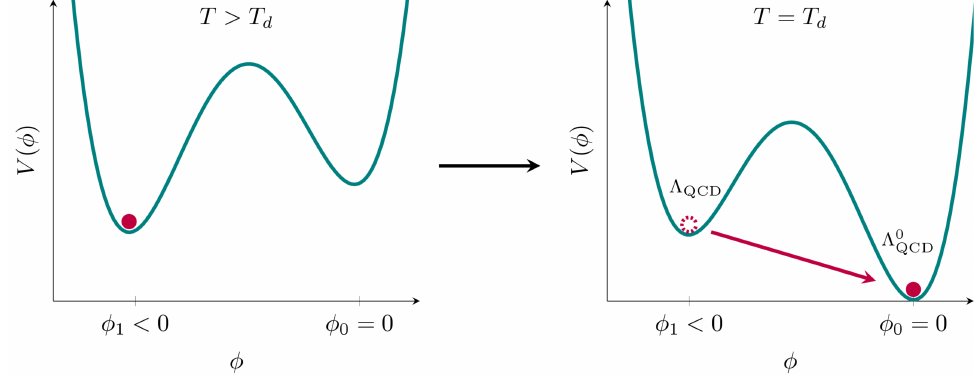
Figure 1 . Schematic representation of the potential V ( φ ) , inducing an effective SU(3) coupling leading to early confinement for T > T